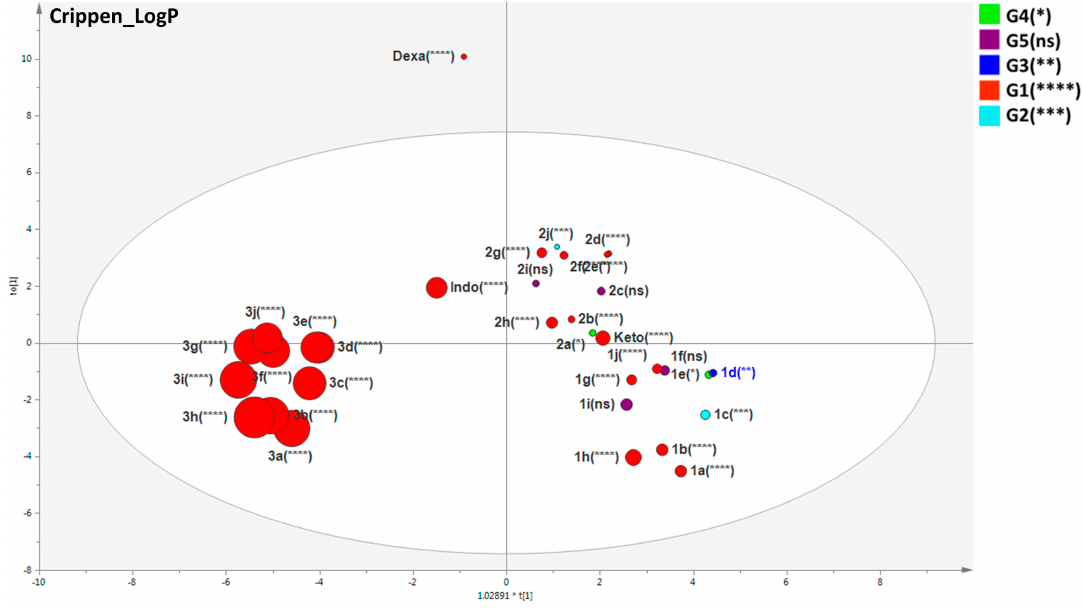
Figure 8. Scatter plot of the supervised O2PLS-DA model using twenty-eight selected descriptors (calculated on PaDEL v.2.2.1 software) explaining the molecular features correlated to the benzophenone derivatives. The size of each variable was defined in the graph properties as being directly correlated to the CrippenLogP to evaluate the values of this feature among all substances. The compounds used as standards in the anti-inflammatory assay (dexamethasone, indomethacin, and ketoprofen) were also evaluated in this model. The asterisks denote the levels of significance in comparison with vehicle ( n = 8). G1 (**** p ≤ 0.0001); G2 (*** p ≤ 0.001); G3 (** p ≤ 0.01); G4 (* p ≤ 0.05), ns = not significant.